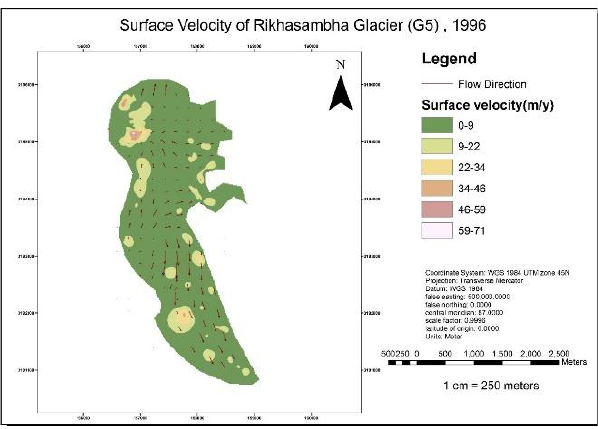
Figure 1. Surface Velocity of Rikhasambha (G5) at 1996.